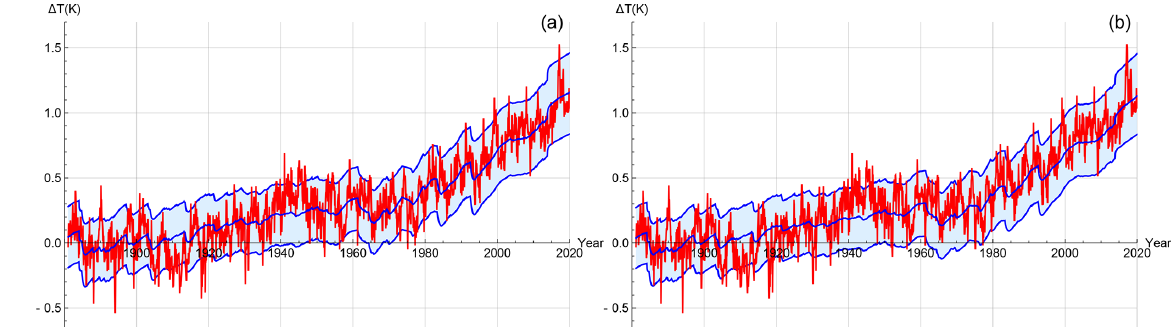
Figure 9. (a) The historical reconstruction (forced temperature response and internal variability) of the FEBE, with parameters calibrated (blue) alongside mean of five observational temperature series (red) at monthly resolution; 90%CIs (due to parametric using F Aer RCP uncertainty and internal variability) are indicated (shaded). (b) Same as left except using F Aer